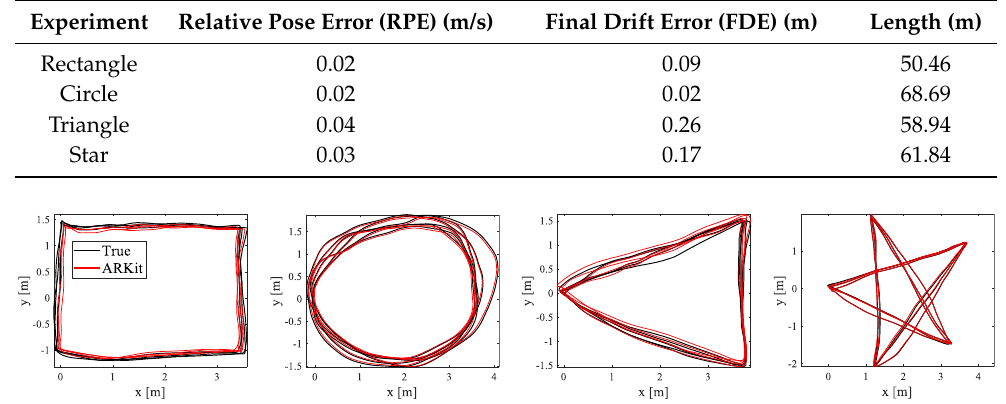
Figure 11. VIO sensor trajectories with ARKit (red) and the ground truth (black). The red and black lines represent the estimated and ground-truth trajectories from ARKit and the OptiTrack motion capture systems, respectively. The true trajectories (black) and the trajectories estimated with Apple ARKit (red) overlapped